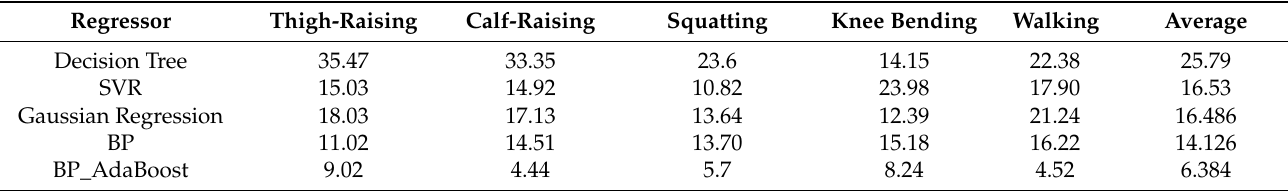
Table 2. Error comparison of various regressors